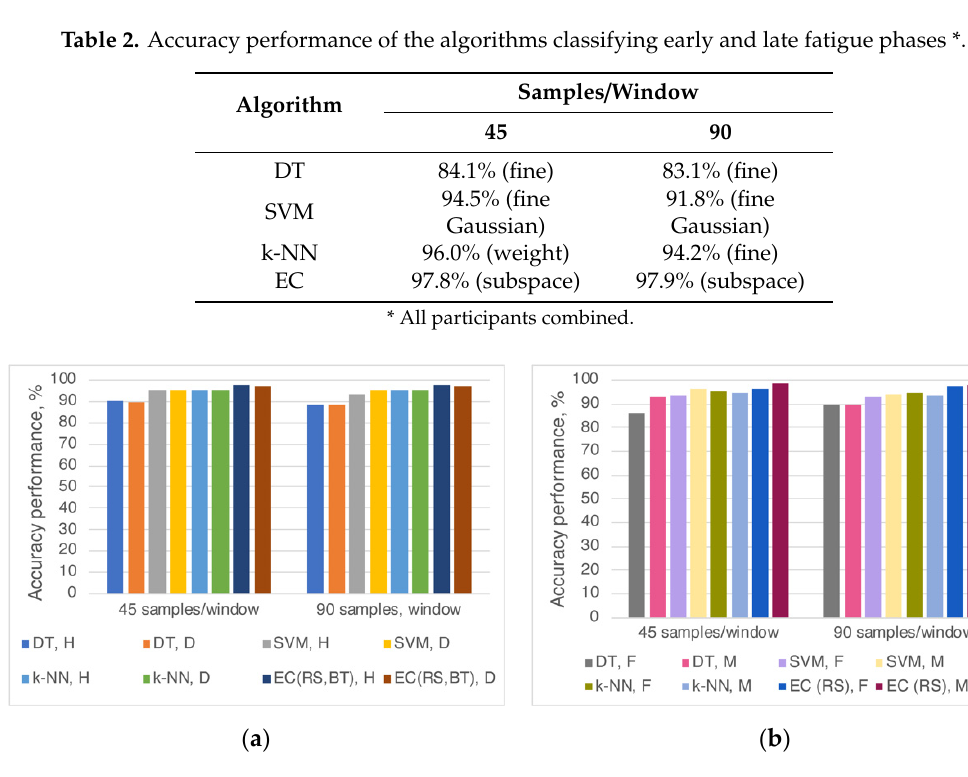
Table 3. Evaluation metrics of the classifiers’ performance.